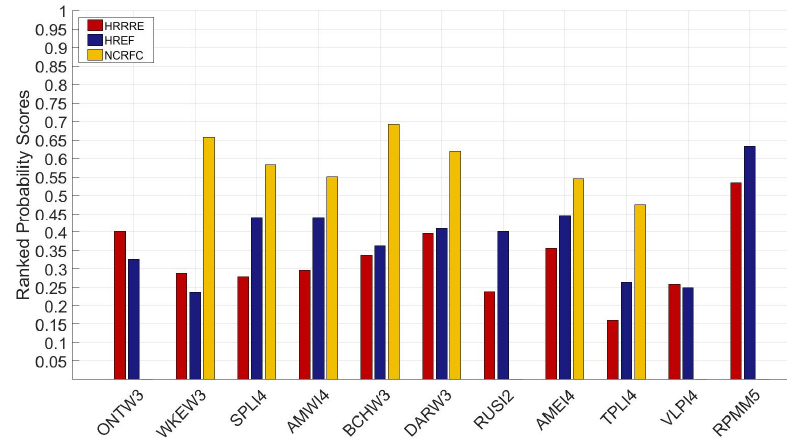
Figure 4. RPS for the eleven basins (labeled using NCRFC abbreviations) arranged in order from the smallest (left) to the largest (right) in area.